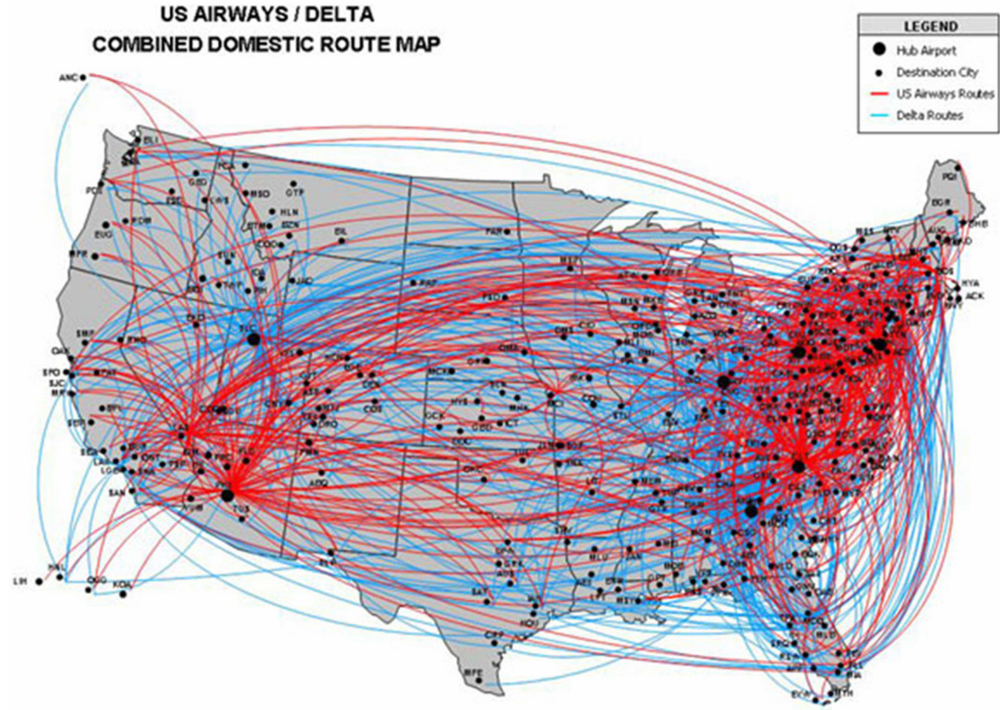
Fig. 12. US Airways and Delta combined domestic routes (source: